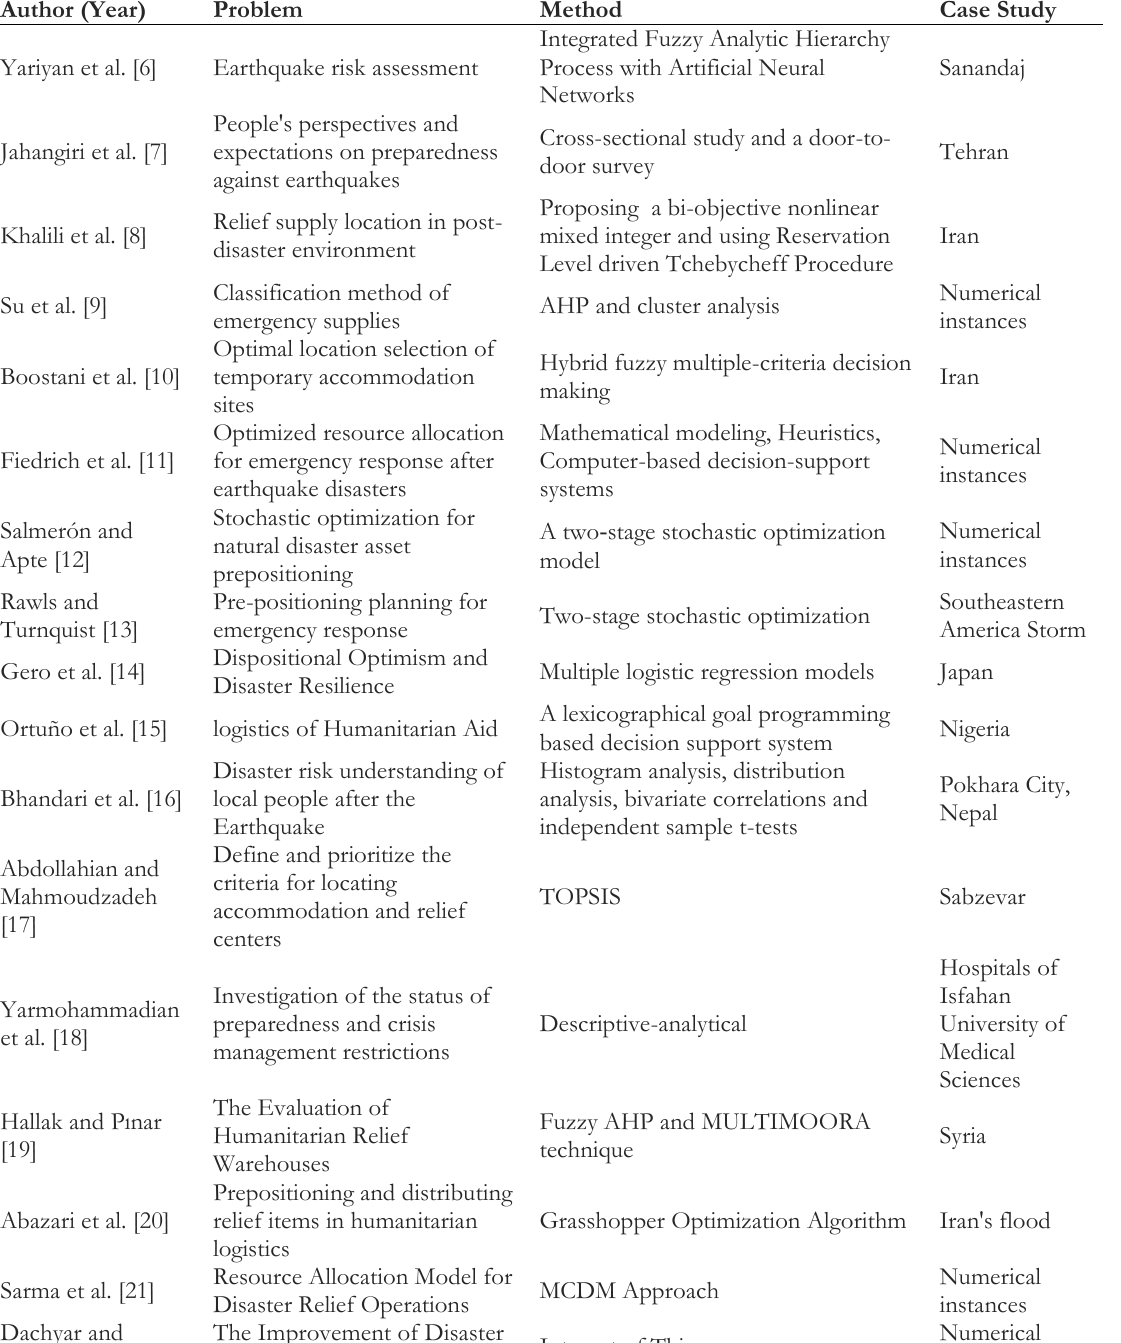
Table 1. The research in the field of crisis